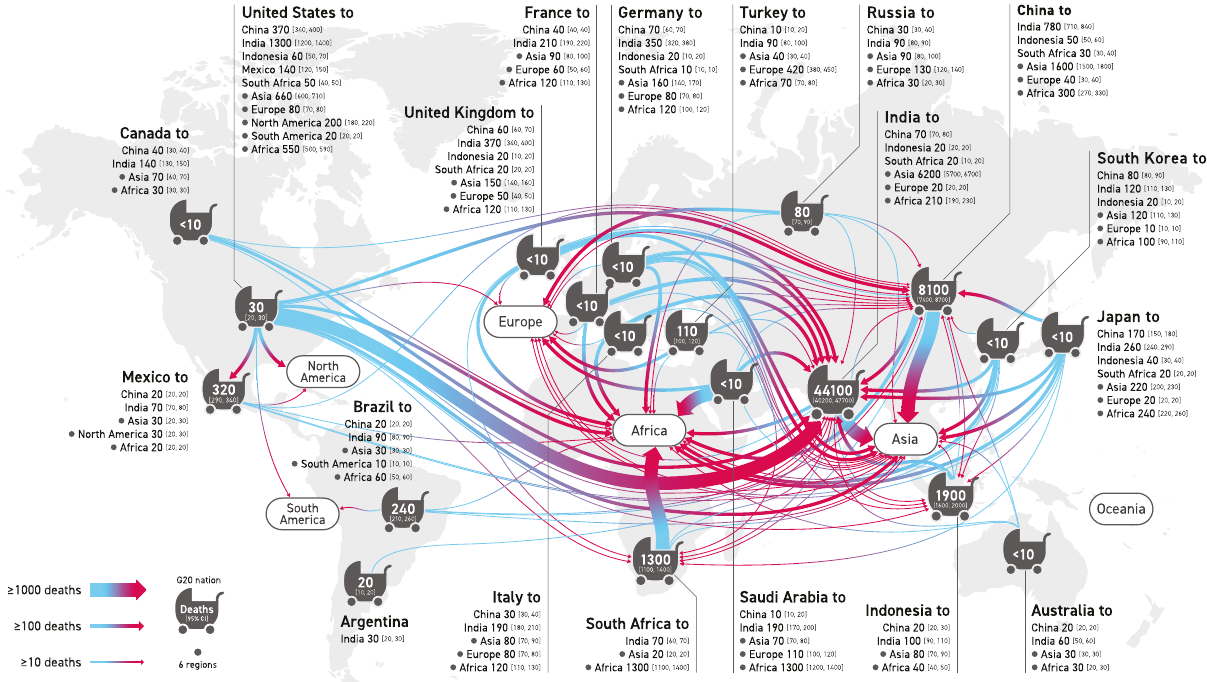
Fig. 5 Relationships between consumer countries and impacted countries ( “ to ” ) for infant deaths (zero to less than fi ve years old) in PM 2.5 premature death footprint of G20